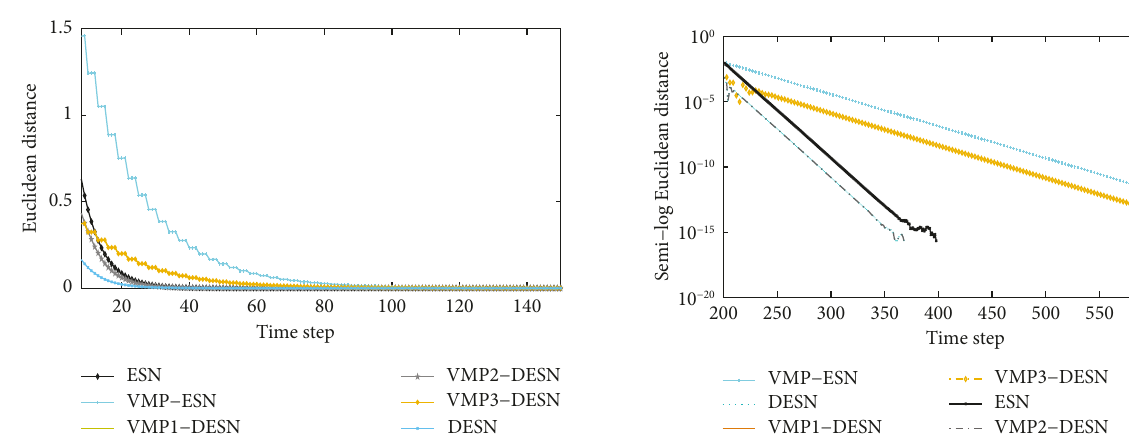
d under different delayed time τ